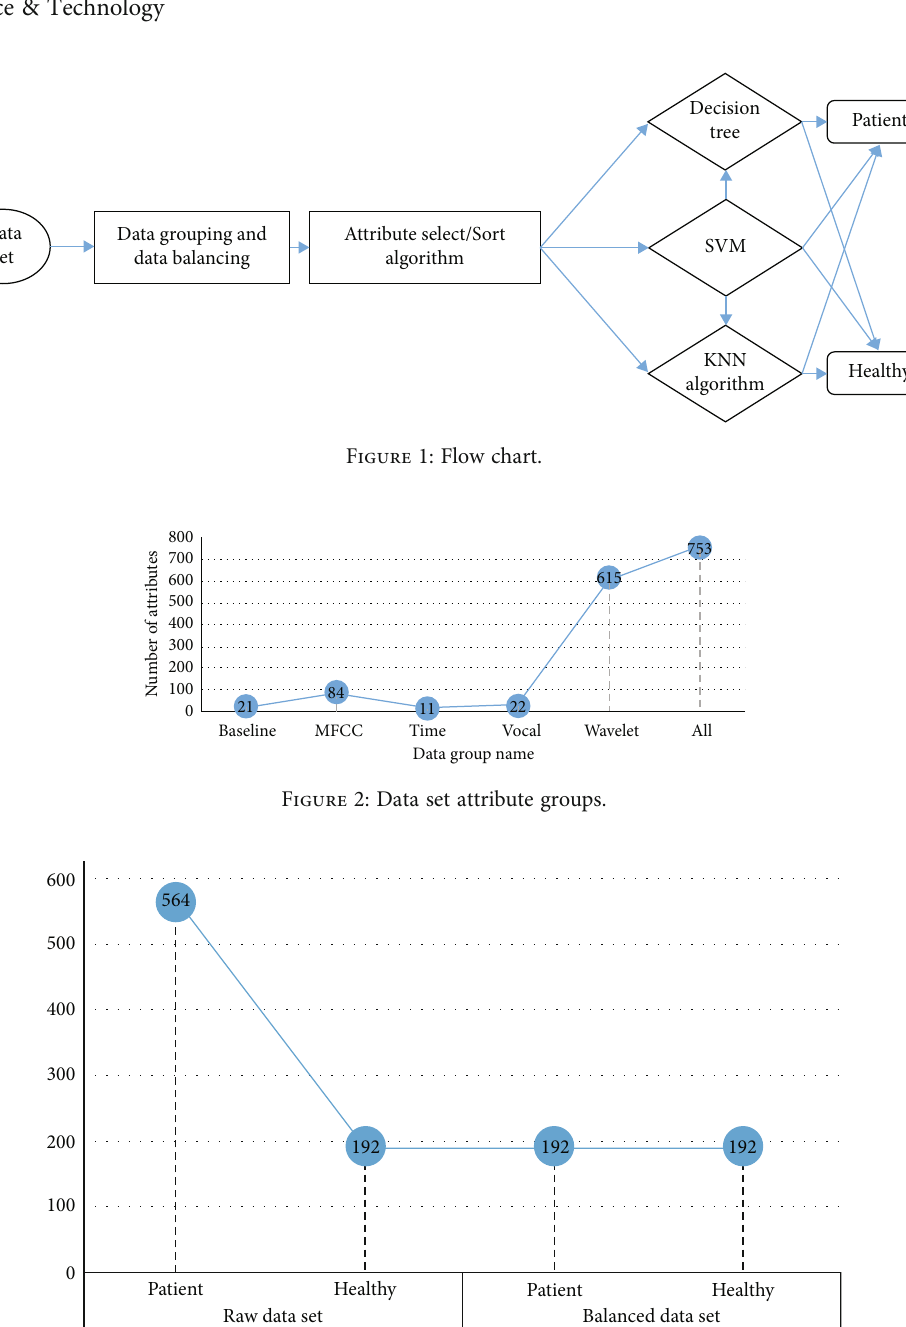
Figure 3: Schematic representation of data set